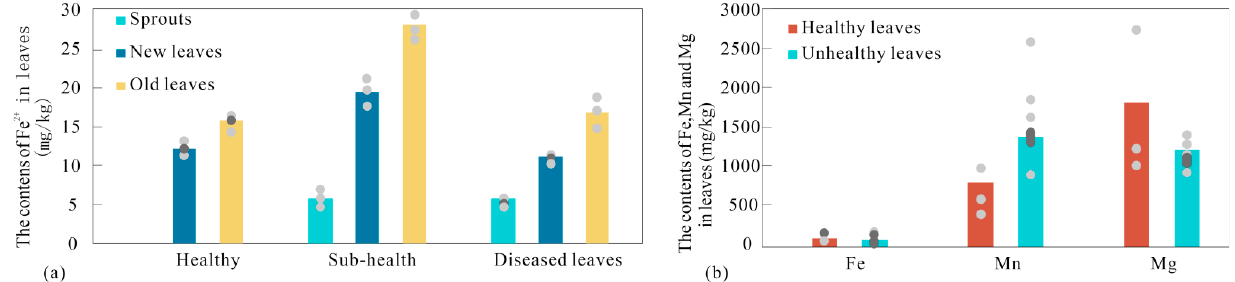
Figure 5. Relationship between leaf growth and contents of Fe, Mn and Mg elements. ( a ) The active iron (Fe 2+ ) in the leaves at different leaf growth stages; ( b ) The total Fe, Mn, and Mg contents in the healthy and unhealthy leaves.